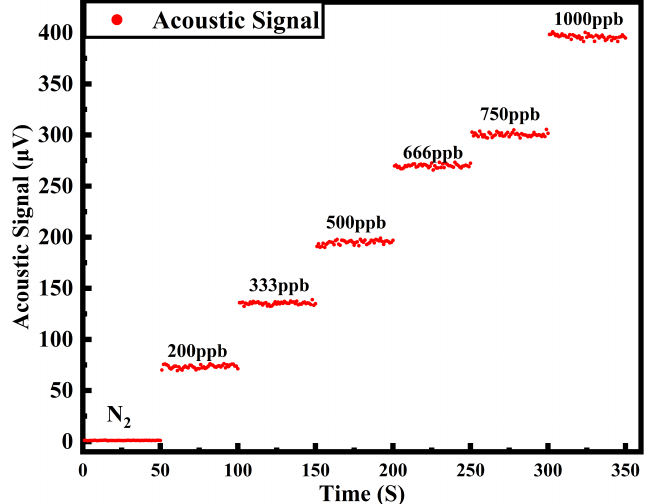
Figure 8. The continuous measurement of NO 2 with different concentrations.